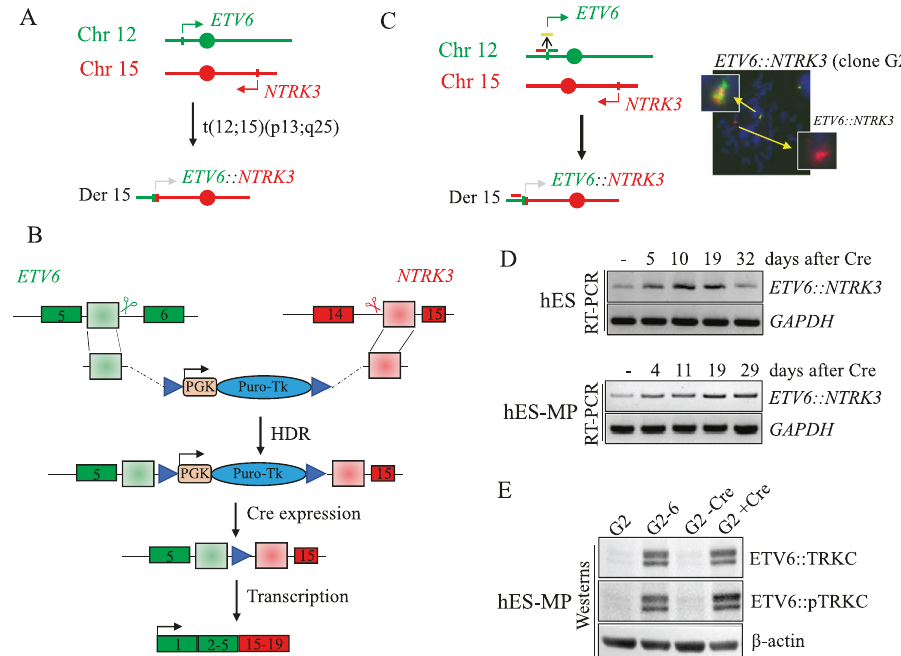
Fig. 3 Generation of the ETV6::NTRK3 chromosomal translocation in hES cells and differentiation to hES-MP. A Breakpoints within ETV6 on chromosome 12 and NTRK3 on chromosome 15 create the ETV6::NTRK3 t(12;15)(p13;q25). B A donor template containing a puromycin selectable marker under the control of a PGK promoter is inserted by HDR at the ETV6 and NTRK3 participating loci after induction of DSBs by sgRNA (scissors). The selectable marker is removed by Cre recombinase allowing the expression of the oncogenic fusion. C Dual color FISH analysis with telomeric (red) and centromeric (green) probes on ETV6 showing the ETV6::NTRK3 translocation on clone G2. D RT-PCR time course (days) for ETV6::NTRK3 fusion after Cre expression in hES and hES-MP cells. The fusion product is detectable in cells before Cre recombination indicating a partial splicing of PGK-Puro sequence. E Western blot analysis showing the ETV6::TRKC fusion protein and the TRKC phosphorylation in hES-MP clone G2-6 and G2 after expression of Cre recombinase. The total ETV6::TRKC protein was detected by pan- TRK antibodies and the TRKC phosphorylation by phospho TRKA/B antibodies (same used for detection of